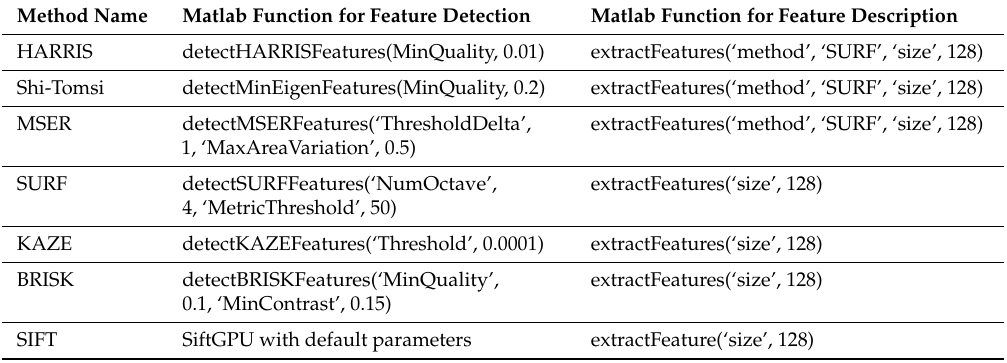
Table A1. The parameters used for feature detection and description in